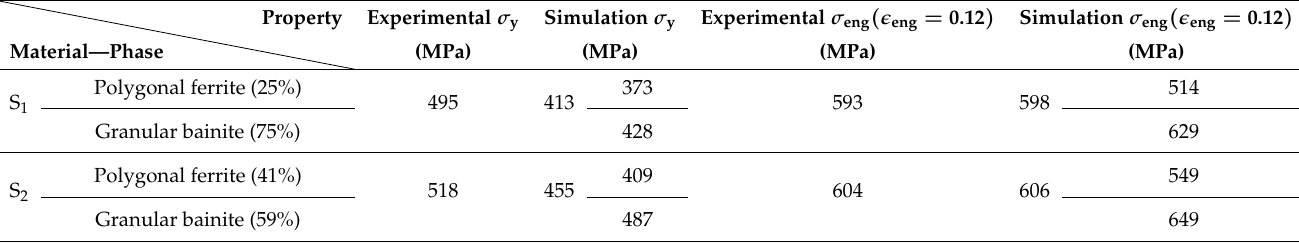
Table 4. Results from the stress–strain curves for materials S 1 and S 2